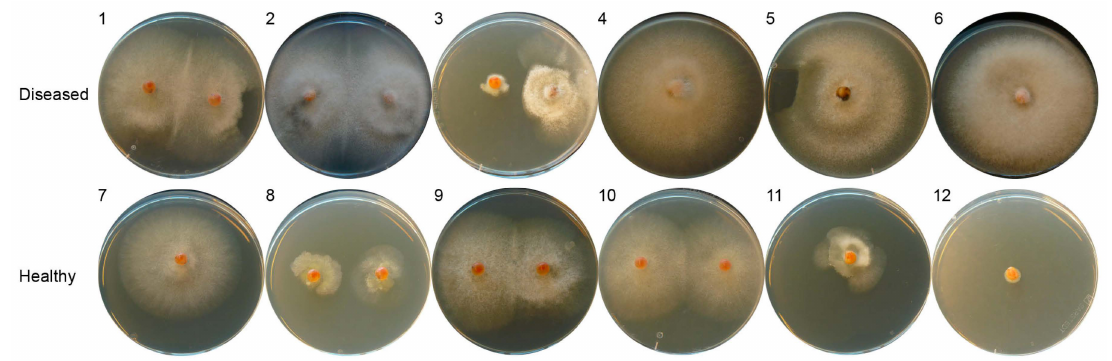
Figure 1. Isolation of salmon egg-associated fungi and oomycetes on potato dextrose agar plates. One or two salmon eggs from a Saprolegnia -infected batch (diseased, replicate No. 1–6) or a healthy batch (replicate No. 7–12) were placed onto the agar plates to allow fungal